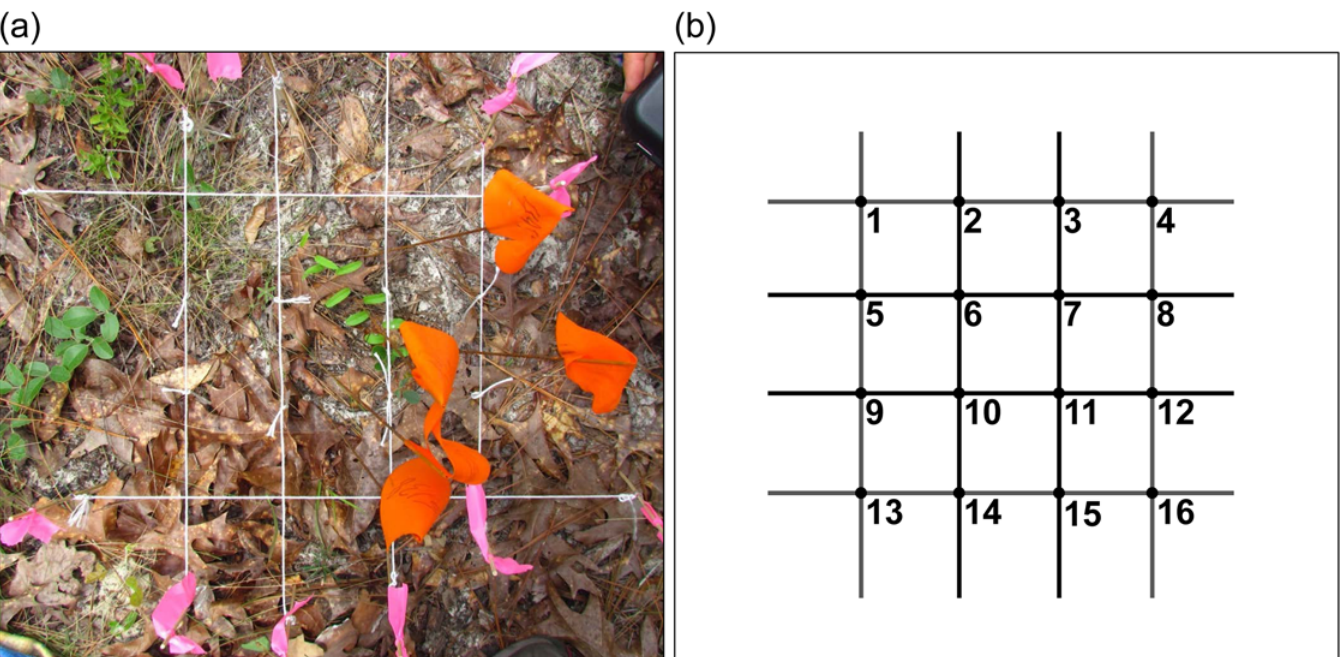
Fig 1. Datum setup and reference point diagram for field excavation of C . irus pupae at Ralph E. Simmons Memorial State Forest, Nassau County, Florida, May-June of 2012. (a) datum; (b) reference point diagram. Photo courtesy of M.